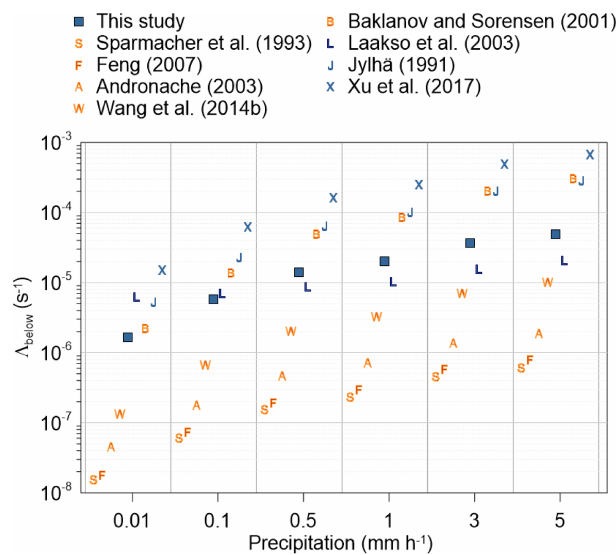
Figure 6. Variations in calculated and measured below-cloud scav- enging coefficients ( (cid:51) below ; s − 1 ) depending on the precipitation intensity (mmh − 1 ). Orange and blue symbols depict the (cid:51) below equation based on theoretical calculations and observation data, re- spectively. The diameter of BC was assumed to be approximately 200nm in the